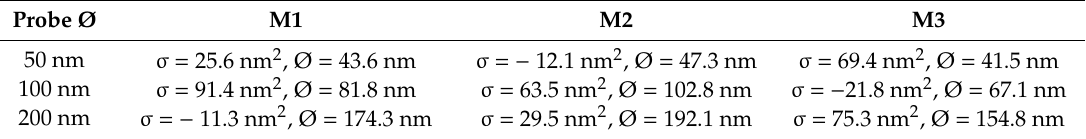
Table 1. σ of each case and diameter Ø of the fluorescent nanoparticle calculated using D. Probe Ø